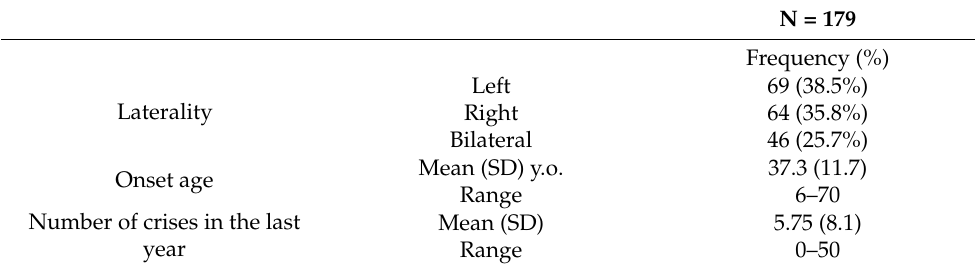
Table 1. Clinical features of MD.